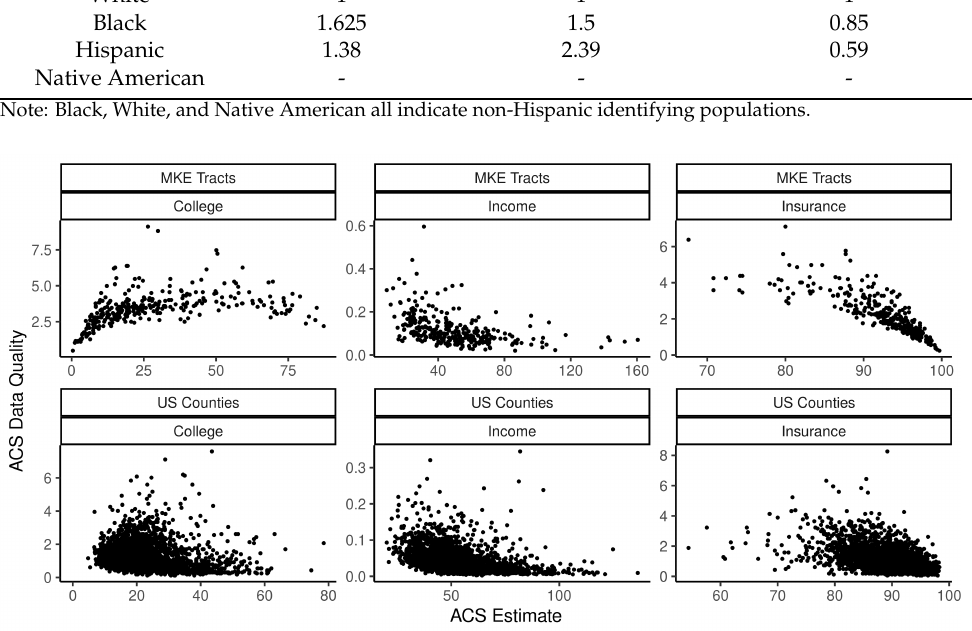
Figure 3. ACS estimates and their data quality measure (CV for income, SEs for the others). Median HH income is reported in thousands of dollars. A single outlying observation of college education at the county level is excluded from the plot (Loving County, Texas, estimated 0% college educated, SE =